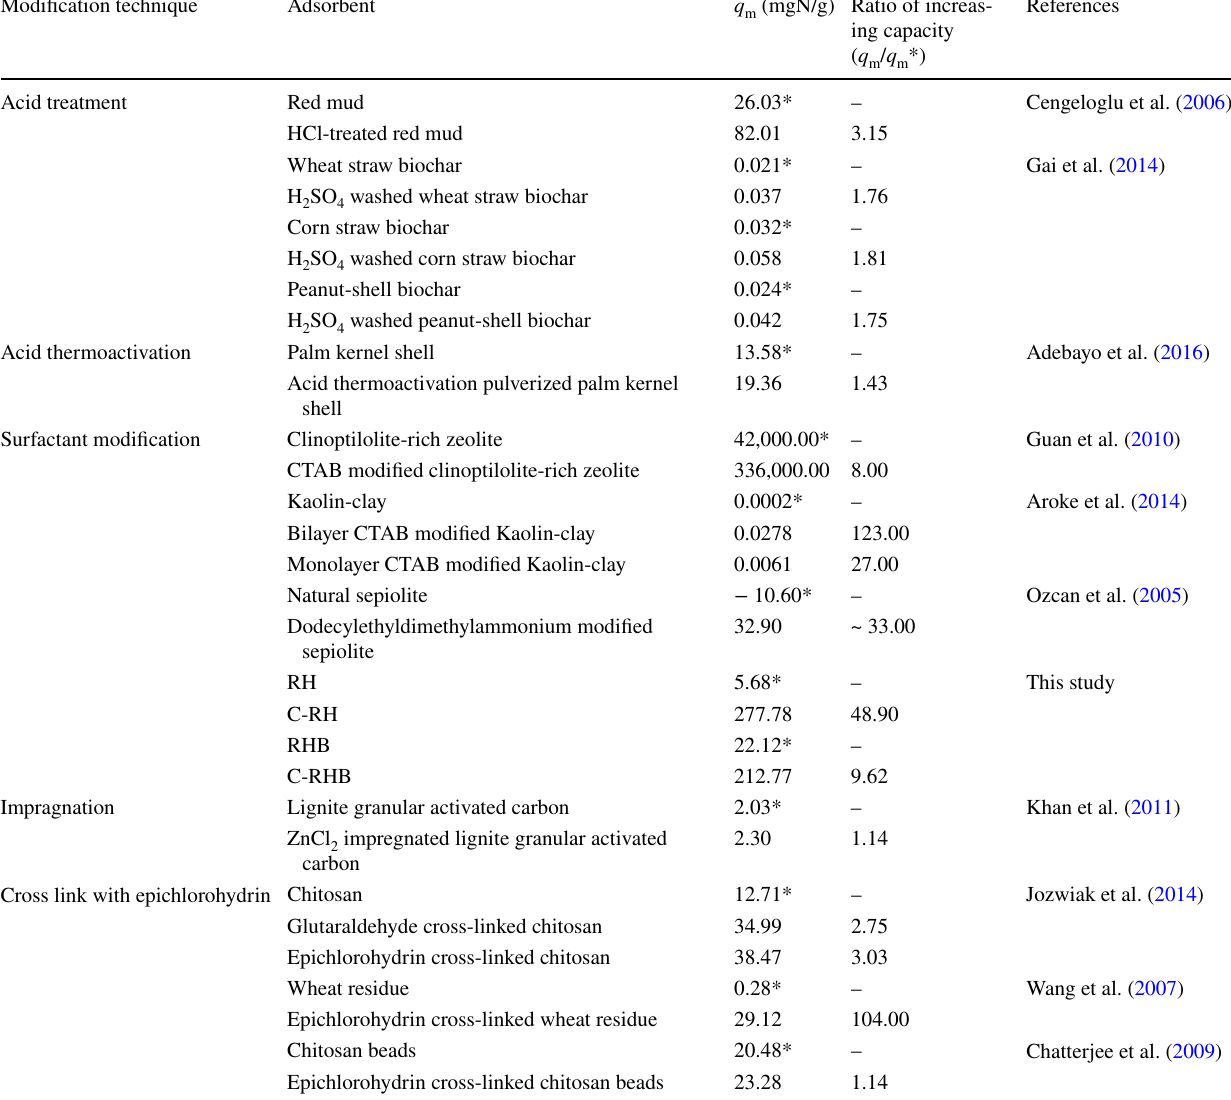
* is unmodified material